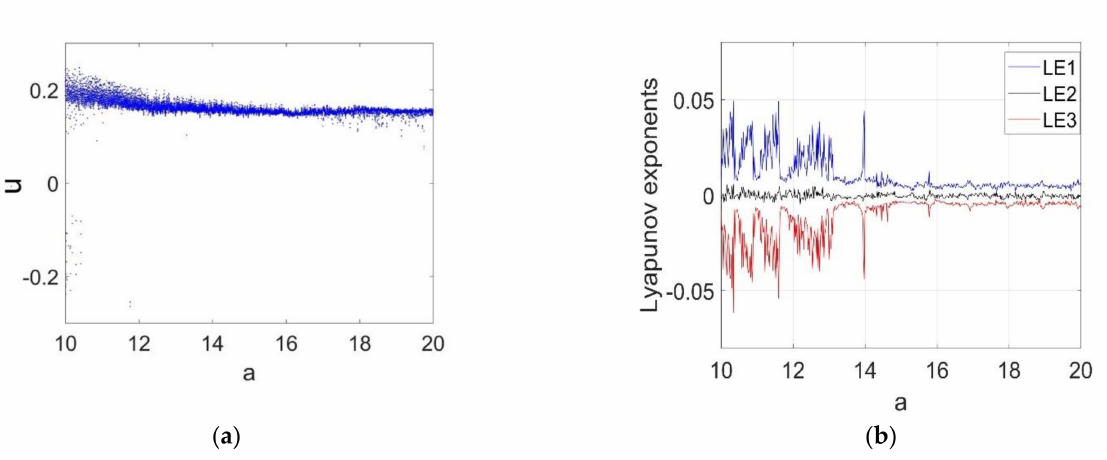
Figure 5. Dynamic study of the chaotic system (4) with ( b , c ) = ( 0.5,1.4 ) : ( a ) The bifurcation diagram with respect to a and ( b ) The Lyapunov exponents